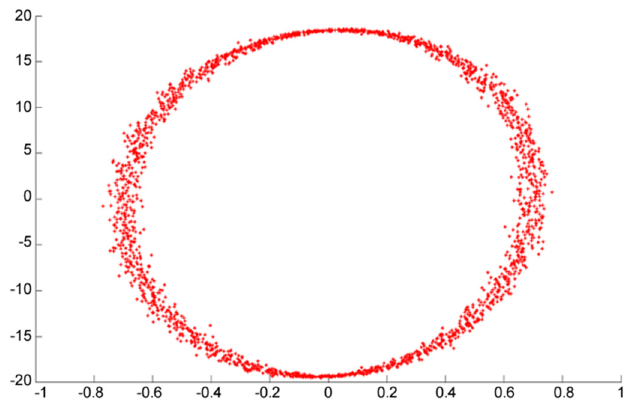
Figure 15. Chaotic trajectory for power system signal with voltage swell disturbance and 5%